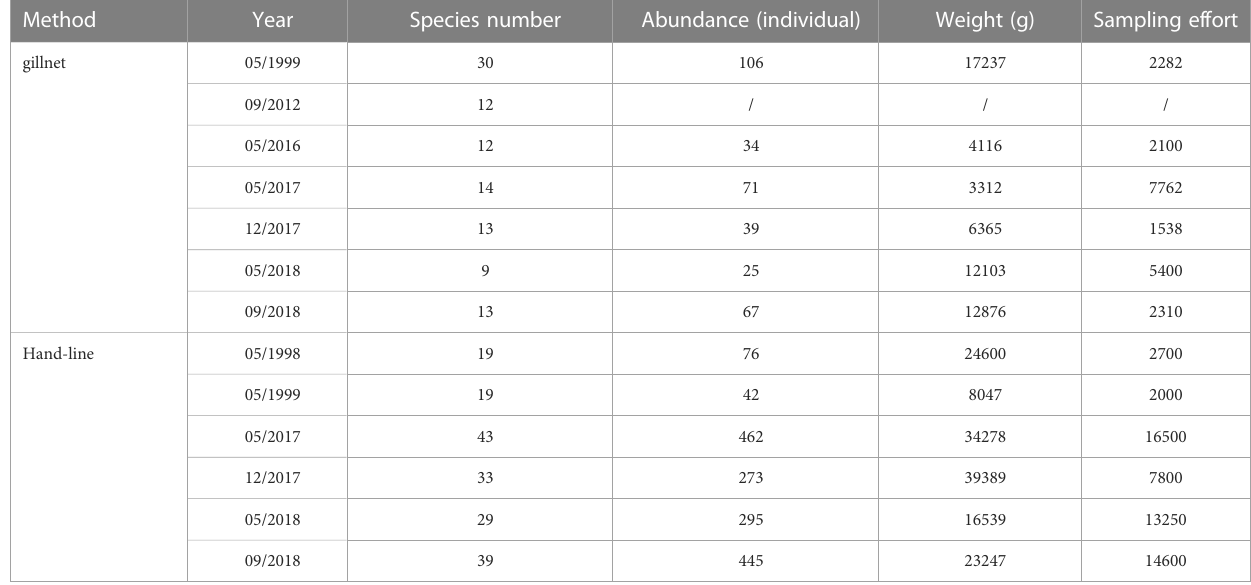
TABLE 2 Total species number, abundance, weight and sampling effort of fi sh specimens in the lagoon of Meiji Reef in the South China Sea during 1998 —